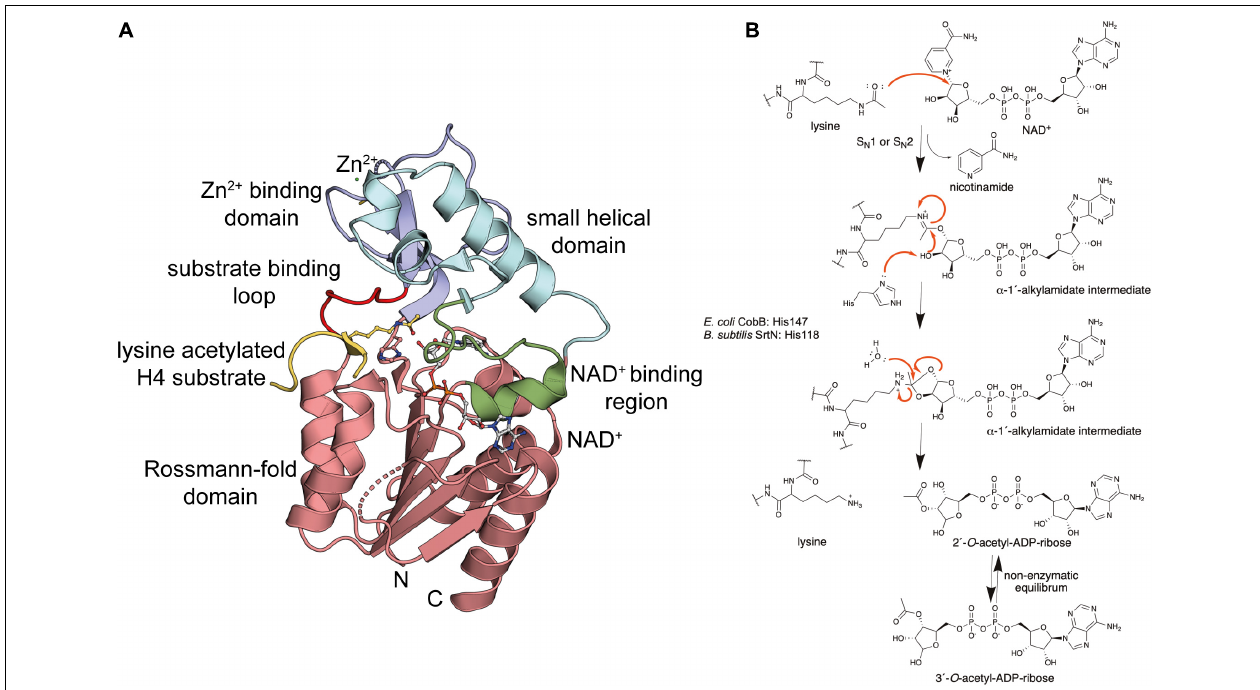
FIGURE 4 | Bacterial sirtuins are NAD + -dependent lysine-deac(et)ylases. (A) Structure of the E. coli sirtuin deacetylase CobB in complex with an lysine acetylated human histone 4 substrate (PDB: 1S5P). The CobB structure was superimposed to a structure of human SIRT2 in complex with NAD + (PDB: 4RMG) to show localization of NAD + . CobB contains a Rossmann-fold domain (salmon) composed of a six-stranded parallel β -sheet flanked by several α -helices containing the NAD + -binding site. An NAD + -binding region (green) contributing to NAD + -binding connecting Rossmann-fold and small helical domain (light blue). The Zn 2 + -binding domain (dark blue) contains a structural Zn 2 + -ion that is coordinated by two pairs of conserved Cys-residues (only two are visible in this structure). The substrate binding loop (red) connects the Zn 2 + -binding domain and the Rossmann-fold domain [the figure was generated with PyMOL v.2.3.4 (Schrödinger LLC, 2000)]. (B) Catalytic mechanism exerted by sirtuins. Sirtuins are NAD + -dependent lysine deac(et)ylases enzymes that use NAD + as stoichiometric co-substrate for catalysis. Initially, the carbonyl-oxygen of the lysine’s ac(et)yl-group as a nucleophile performs an attack of the electrophilic C-1 (cid:48) of the NAD + ribose. This results in fast release of nicotinamide subsequent formation of a C-1 (cid:48) - O -alkylamidate intermediate. Several steps are needed to resolve this intermediate. These include a hydrolysis step, as shown, resulting in formation of the deac(et)ylated lysine and 2 (cid:48) - O -acetyl-ADP-ribose, which exists in a non-enzymatic equilibrium with 3 (cid:48) - O -acetyl-ADP ribose [figure redrawn and modified from Smith and Denu (2006), Ali et al. (2018), Teixeira et al. (2020), and Blasl et al.